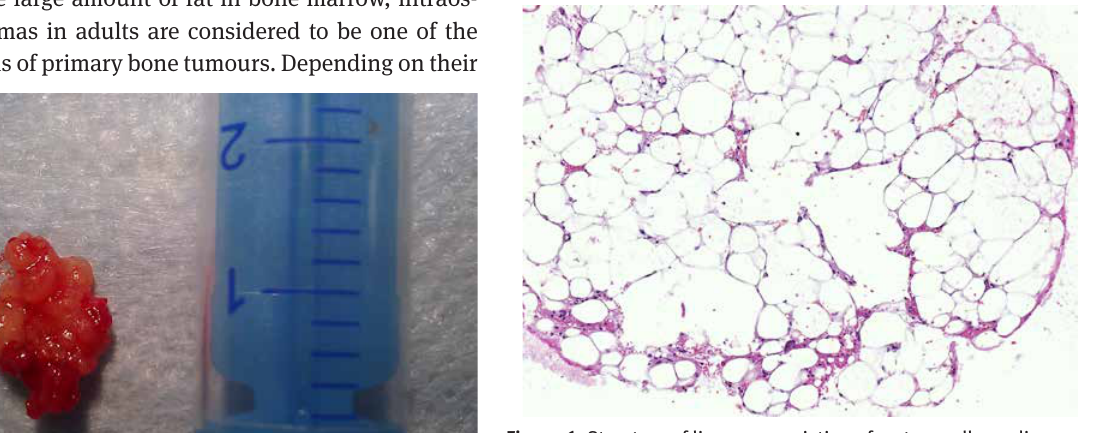
Figure 6: Structure of lipoma, consisting of mature yellow adipose; tissue with numerous capillaries. Hematoxylin-eosin staining. Magnification